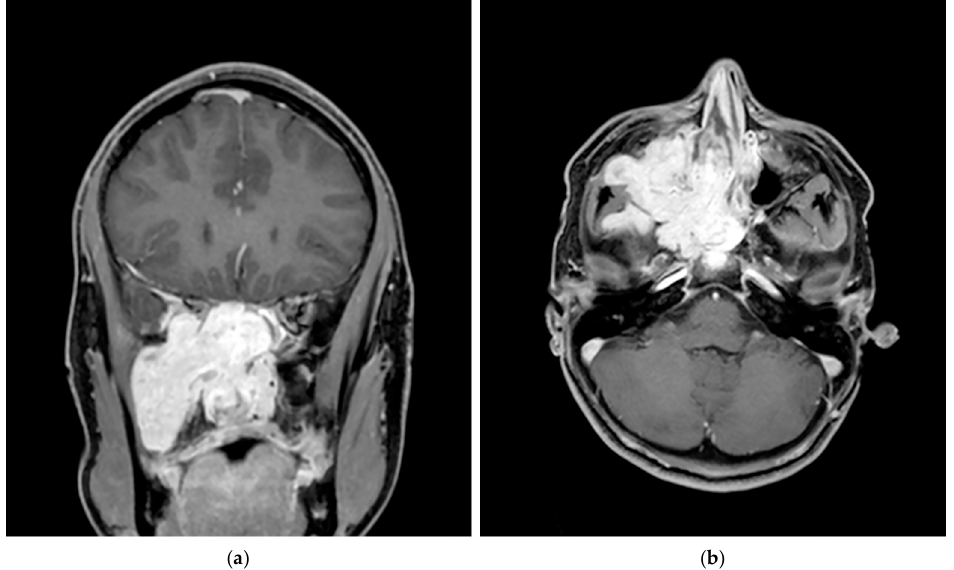
Figure 1. Preprocedural MRI scan (Gd-enhanced T1 Gradient-Echo 3D): coronal ( a ) and axial ( b ) views showing large JNA of right nasopharyngeal mass with expansion of the pterygopalatine fossa and extension into the infratemporal fossa.